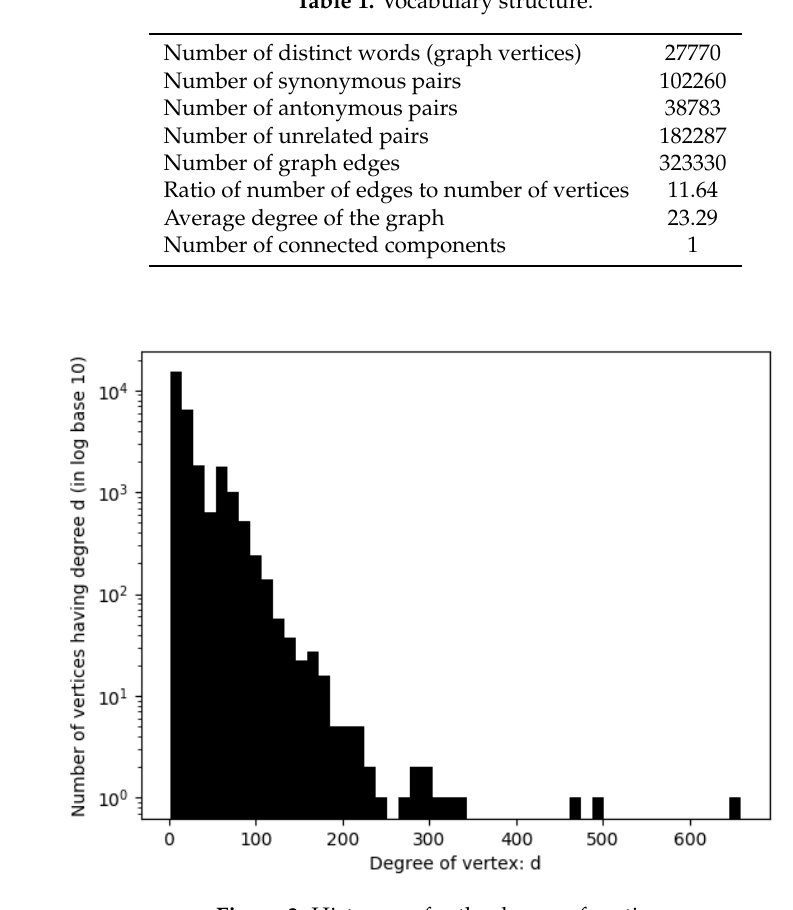
Figure 3. Histogram for the degree of